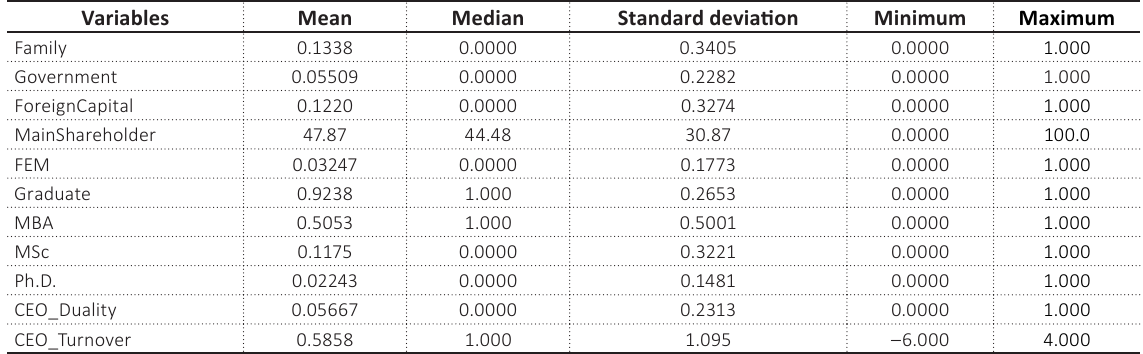
Table 3. Statistics of variables used in the robustness